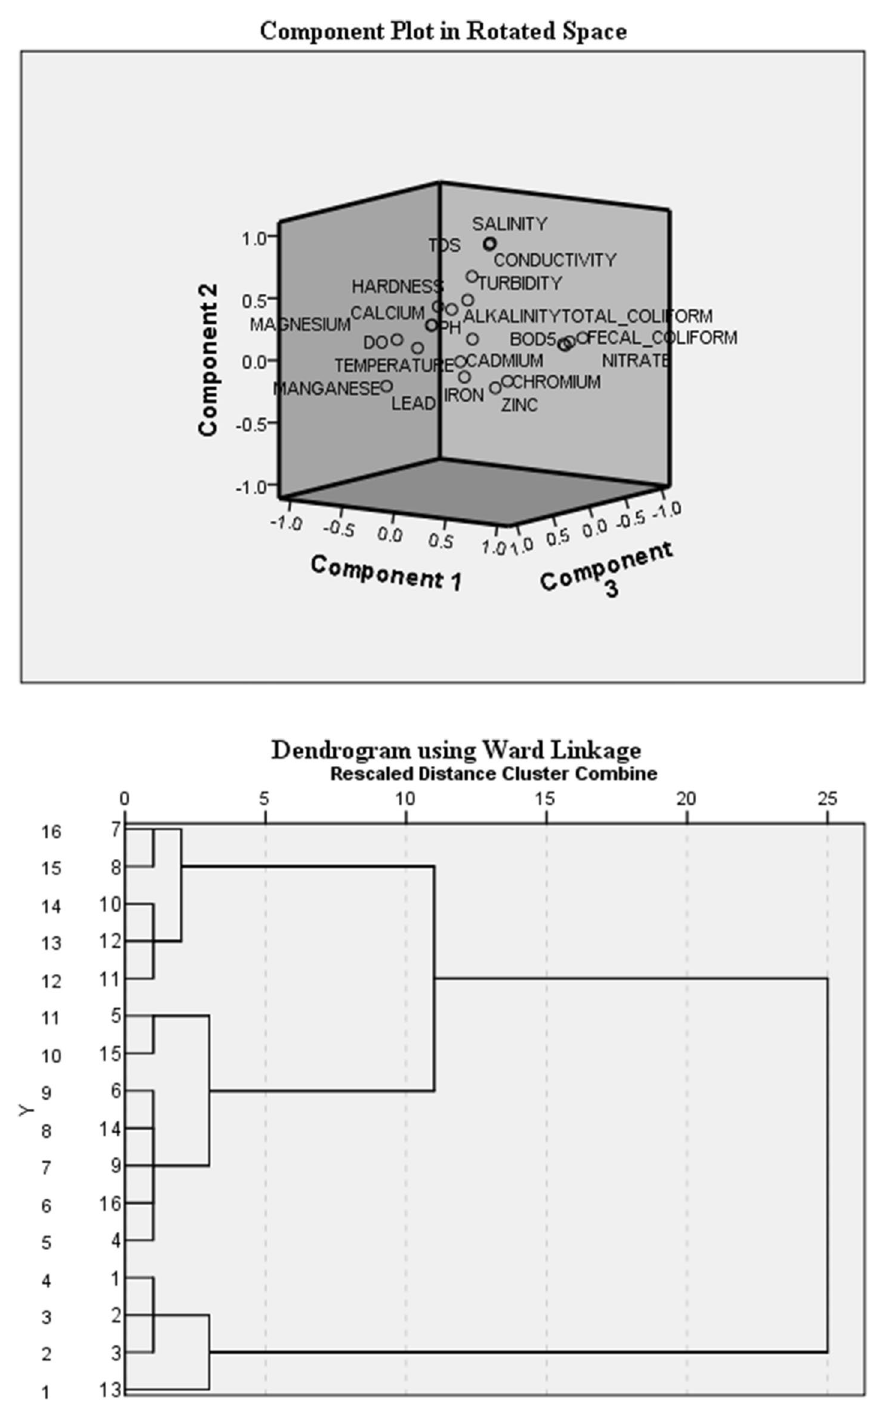
Fig. 2 Component plot for rotated space for boreholes water in Okobo